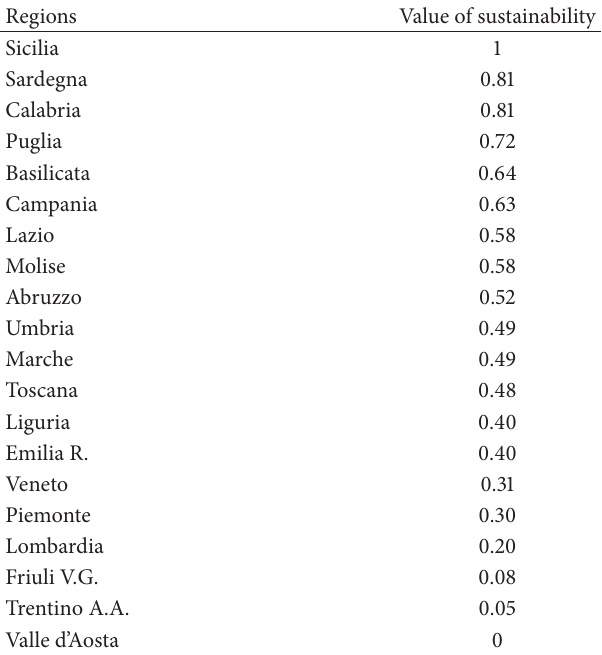
Table 3: Ranking of alternative